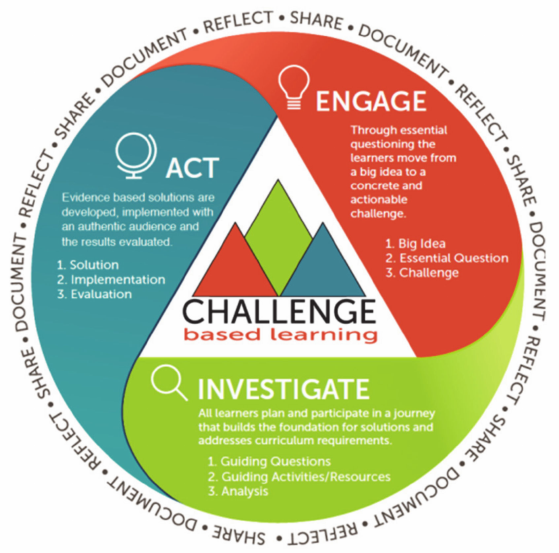
Figure 1. Challenge Based Learning Framework (CBL; Adopted from Nichols et al., 2016, p. 11)